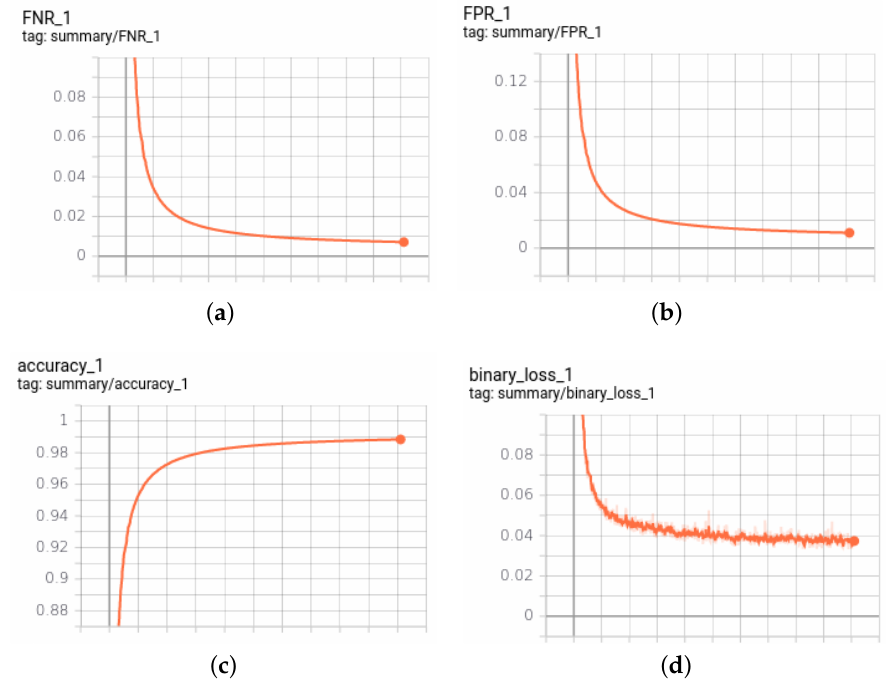
Figure 6. Training process of the RailNet. ( a ) FNR result. ( b ) FPR result. ( c ) Accuracy result. ( d ) Loss function